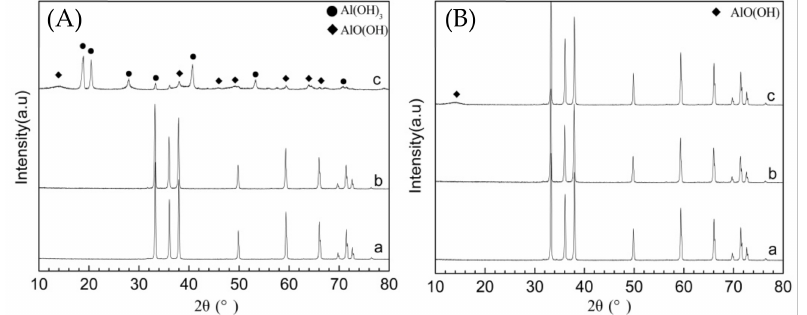
Figure 6. XRD patterns of AlN powders modified by block copolymer at 50 ◦ C with different hydrol- ysis times: ( A ) a original AlN powders; ( A ) b hydrolyzed for 8 h modified powder; ( A ) c hydrolyzed for 14 h modified powder; ( B ) a original AlN powder; ( B ) b hydrolyzed for 7 h micro-crosslinking modified powder; ( B ) c hydrolyzed for 14 h micro-crosslinking modified